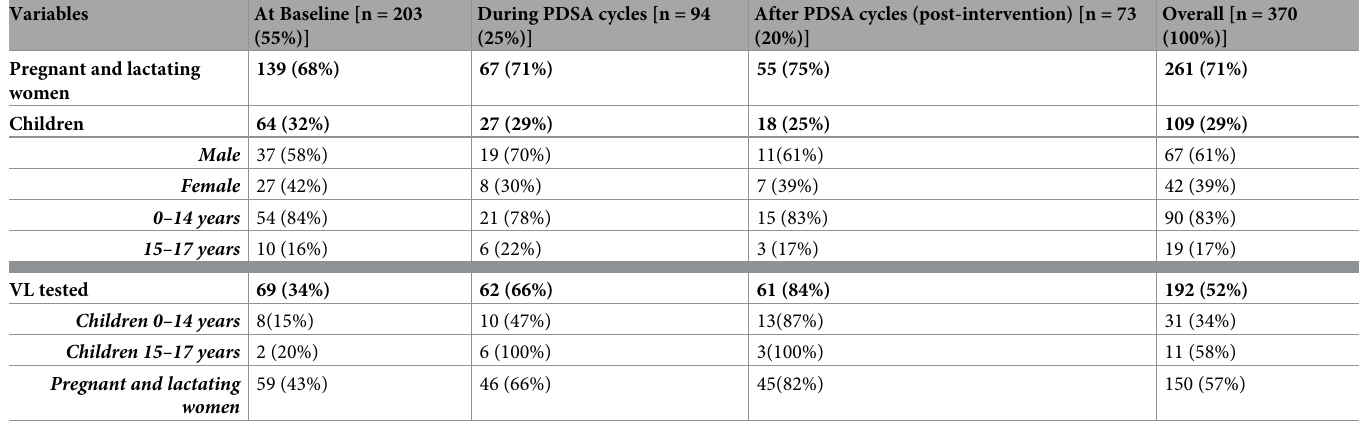
Table 2. Descriptive characteristics of study participants and VL testing data.